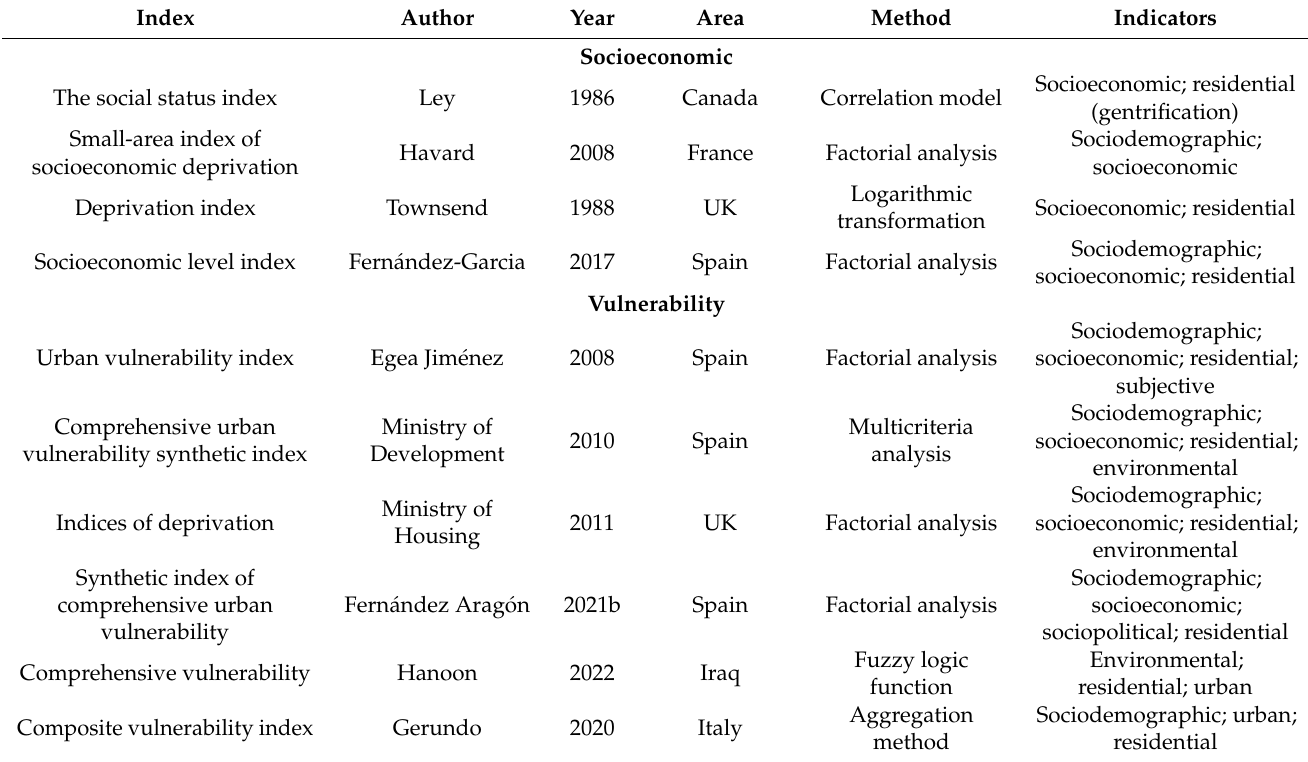
Table 1. Vulnerability and/or inequality